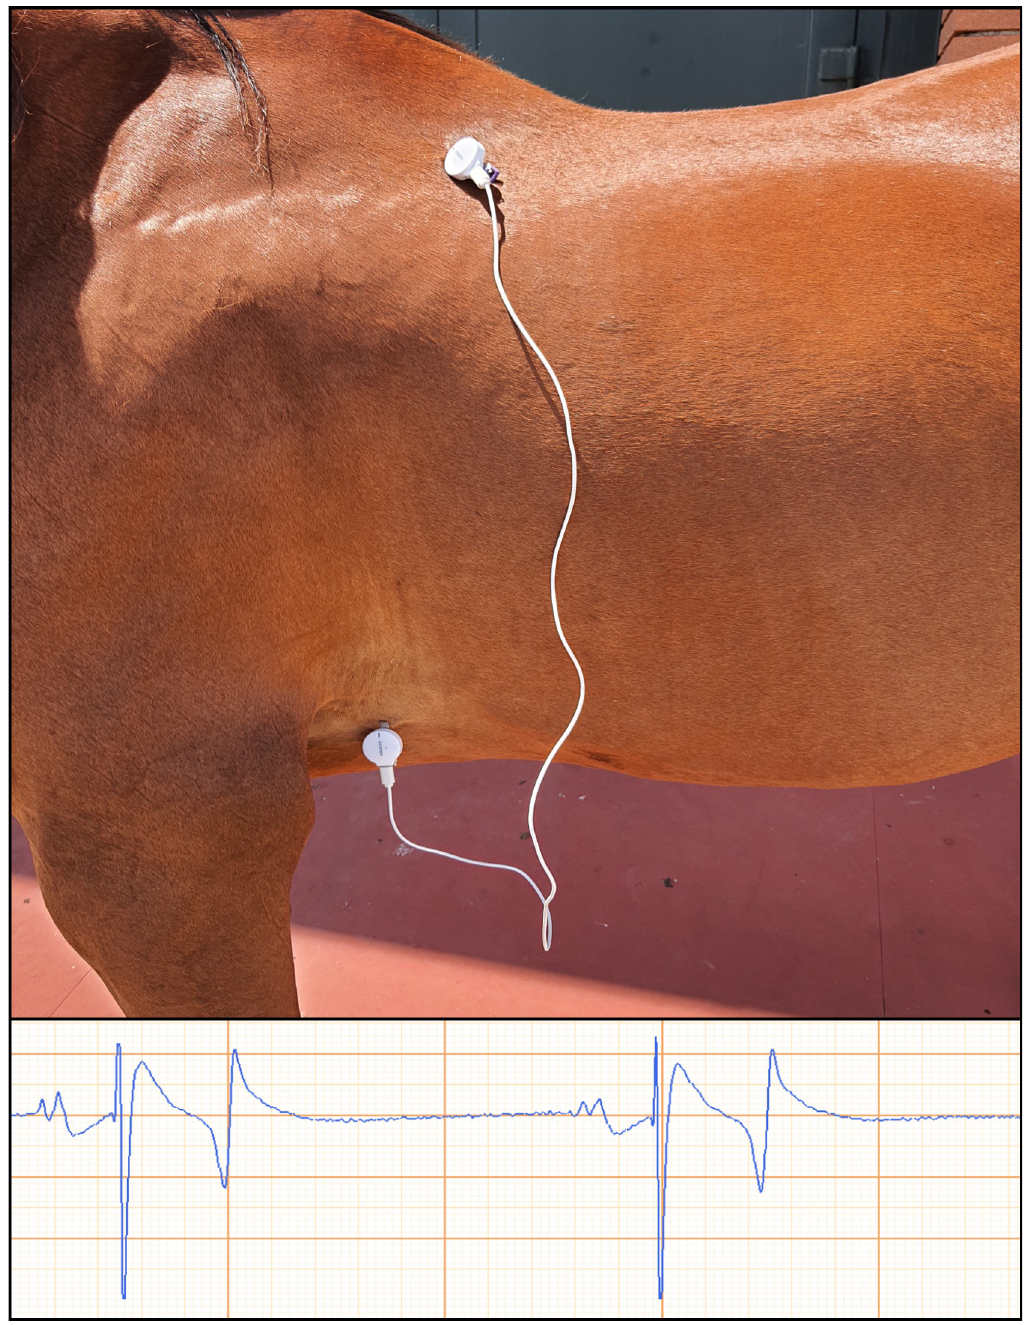
Fig 3. Modified base-apex (MBA) placement of the smartphone ECG (spECG) electrodes. complexes on 15 cm and multiplying the result by 10 for the spECG (paper speed of 25 mm/s). Mean HR was calculated as the mean value of three independent HR calculations from three different areas on the ECG tracings. The duration of each wave or interval was calculated as the average of the measurements of three randomly selected heartbeats.